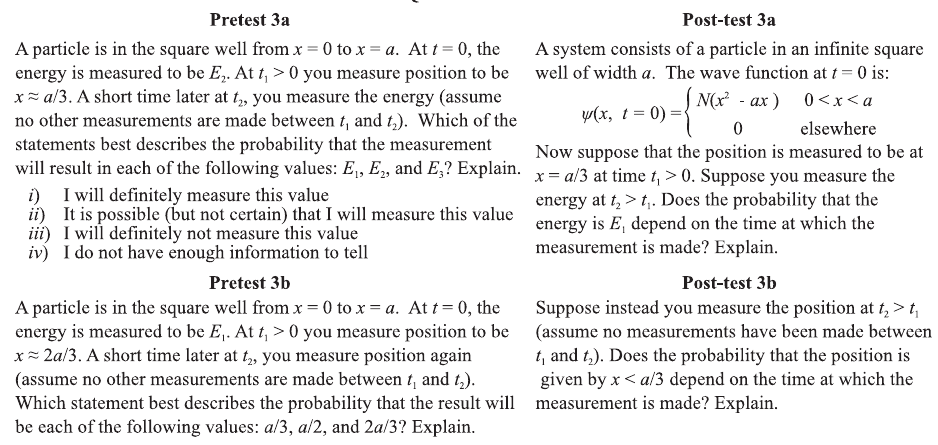
FIG. 6. Several questions about the effects of measuring position. The pretest was given prior to the final tutorial in the sequence, but after lecture instruction and the first two tutorials. The post-test was given after completion of the full sequence, as part of the same exam as post-tests 1 and 2. The text in the figure has been edited for length.